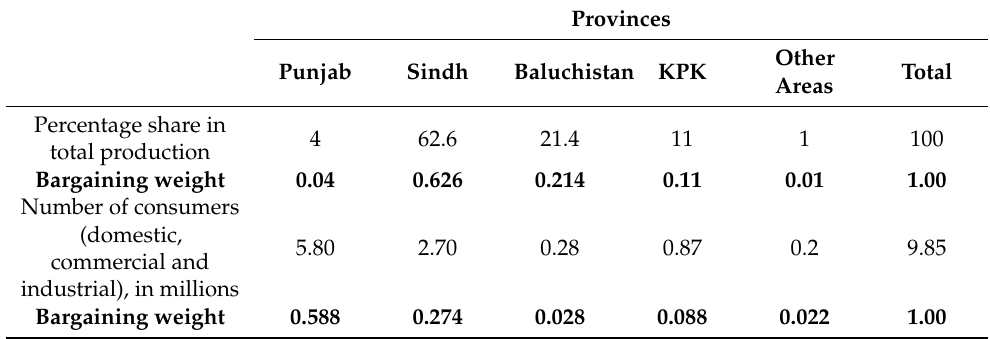
Table 4. Production of gas in provinces of Pakistan, number of consumers, and their bargain- ing